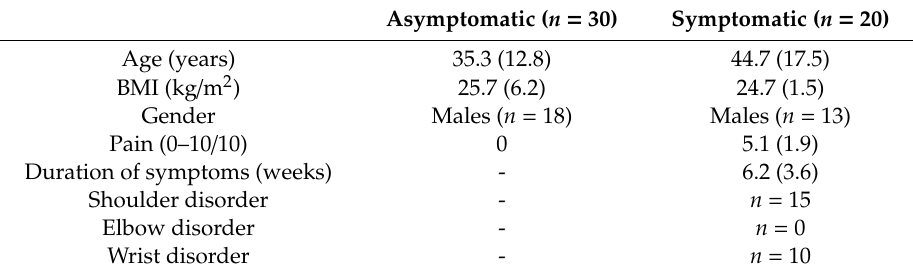
Table 1. Characteristics of the participants.